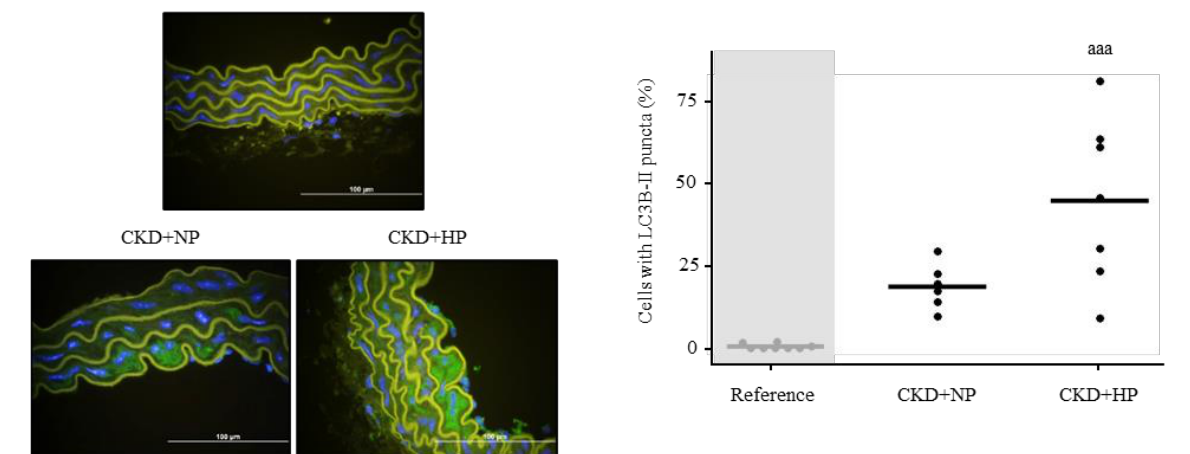
Figure 7. In vivo effects of chronic kidney disease (CKD) and dietary phosphorus intake on aortic autophagy. Representative images of LC3B-II and its quantification in aortas from Sham (Reference) and CKD mice fed NP or HP diet for 14 weeks. Each inset indicates the relative scale in µm. aaa p < 0.005 vs. Reference.